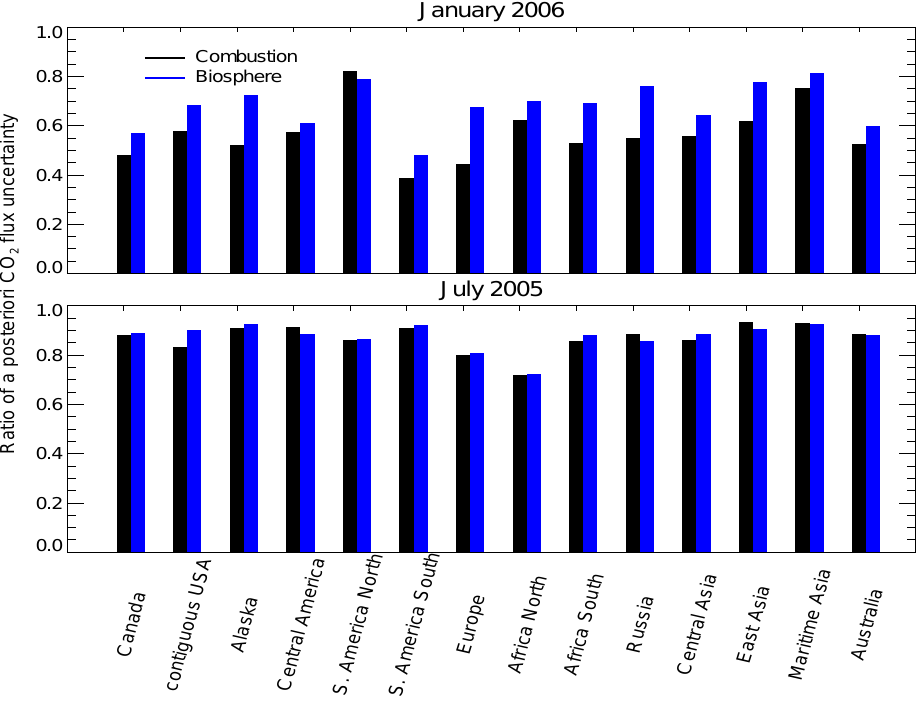
Fig. 7. Ratio of a posteriori CO 2 surface flux error between a joint CO 2 -CO inversion and a CO 2 -only inversion for the different regions in Fig. 6. The errors are measured as the square roots of the diagonal terms of the a posteriori error covariance matrix ˆ S . The inversions used 14 days of pseudo satellite data sampled along the A-train orbit in January 2006 (top) and July 2005